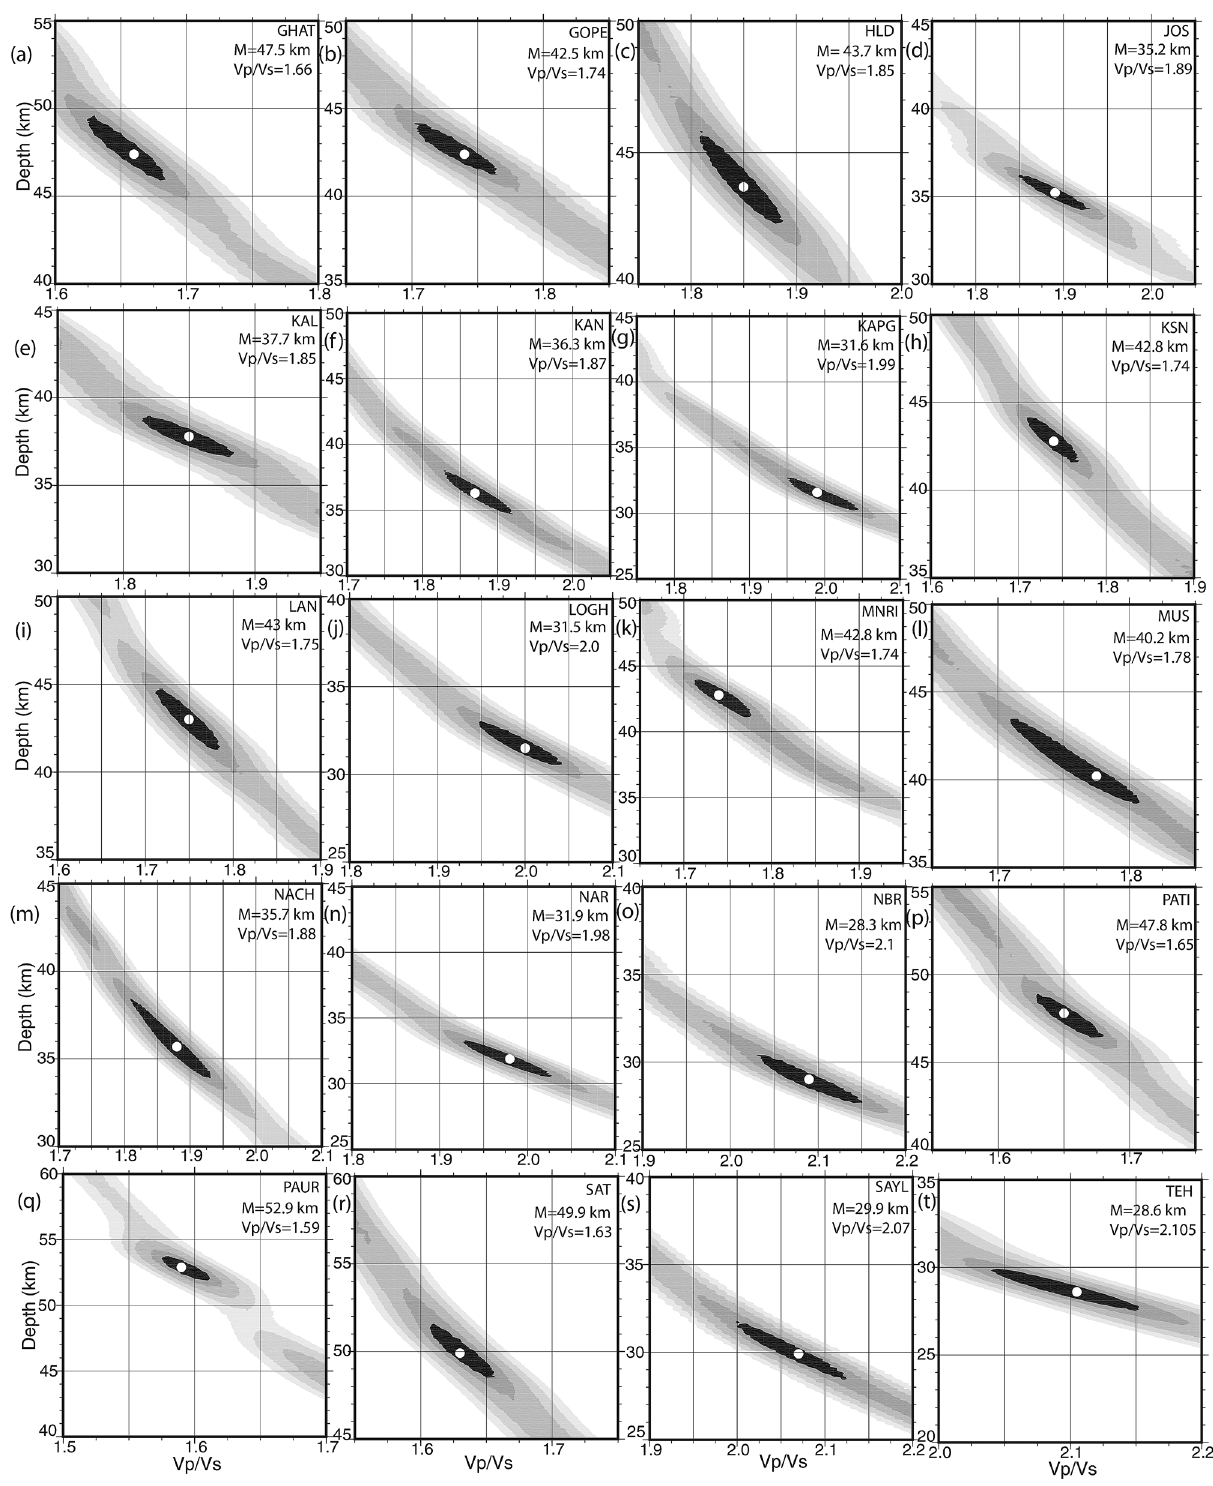
Figure 3. H–K Stacking of PRFs at 20 broadband seismograph sites in the KG Himalaya: ( a ) GHAT, ( b ) GOPE, ( c ) HLD, ( d ) JOS, ( e ) KAL, ( f ) KAN, ( g ) KAPG, ( h ) KSN, ( i ) LAN, ( j ) LOGH, ( k ) MNRI, ( l ) MUS, ( m )